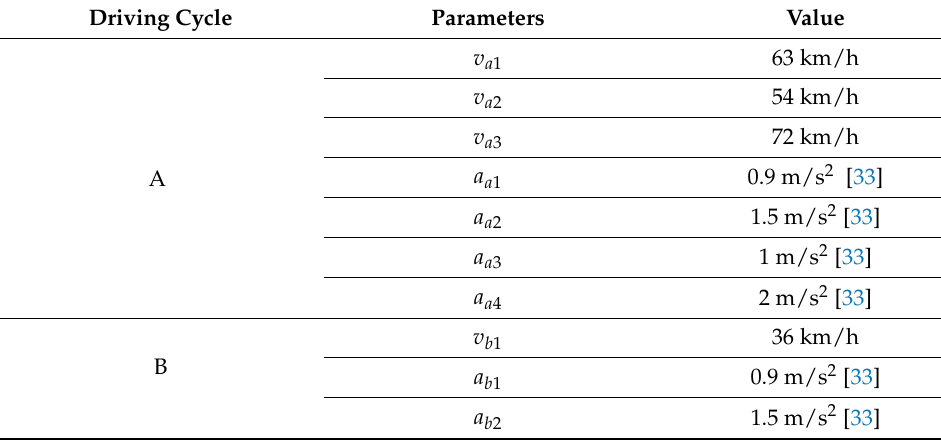
Table 8. Parameters of driving